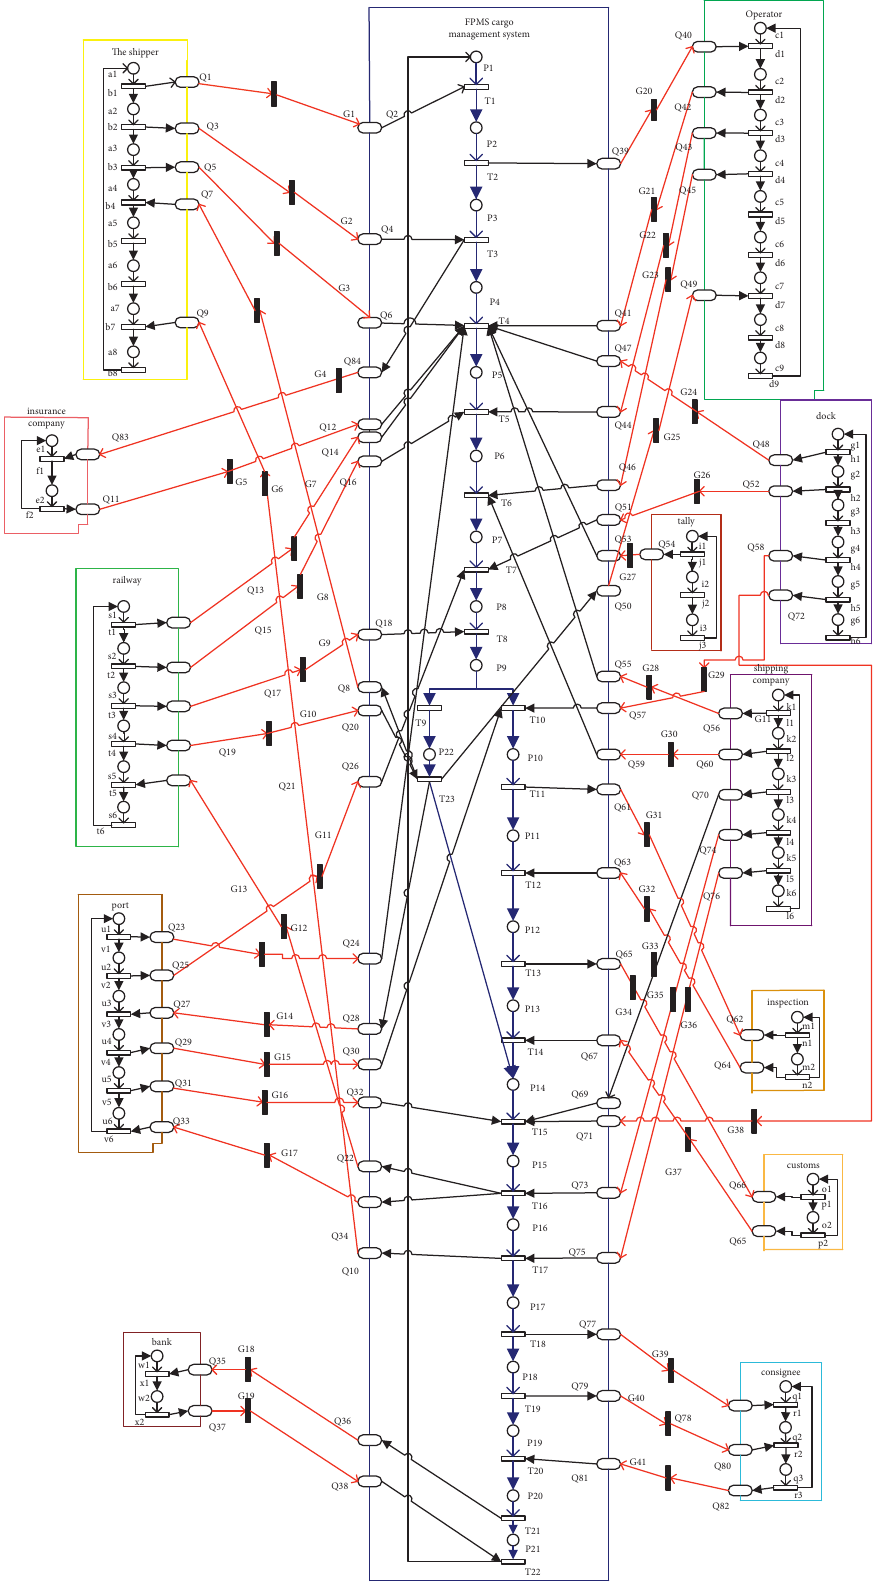
Figure 7: FPMS container export information flow model based on